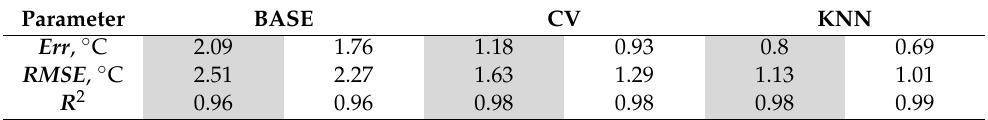
Table 6. Models’ performances. White background—model evaluation using all features, gray background—model evaluation with high-correlated features.